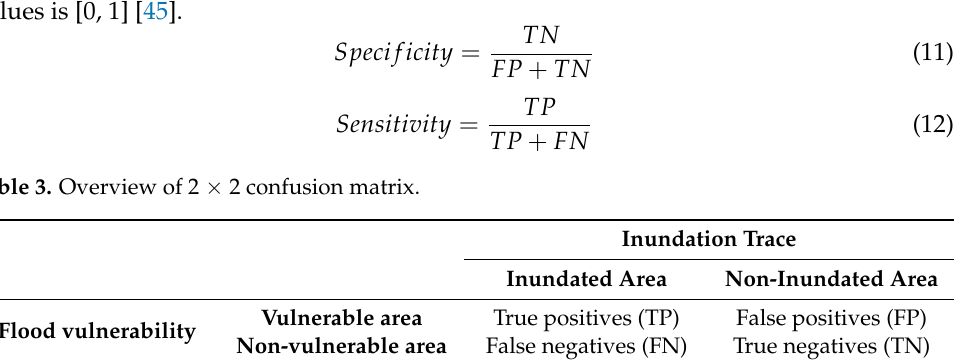
Inundation Trace Inundated Area Non-Inundated Area